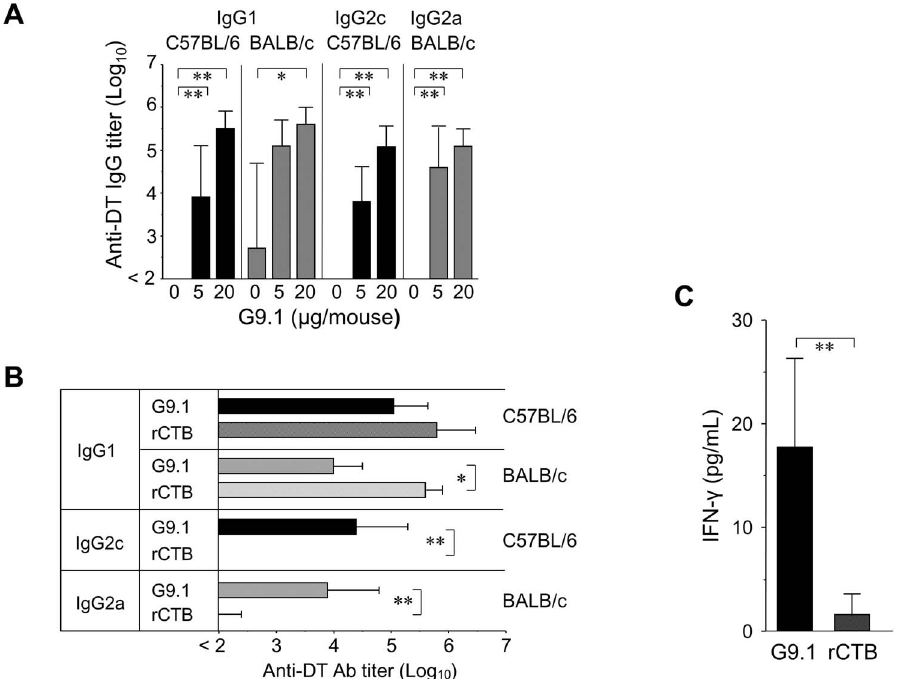
Figure 4. Nasally administered G9.1 induced both IgG1 and IgG2a/c production. A , C57BL/6 and BALB/c mice were immunized as described in Fig. 3. B, C57BL/6 and BALB/c mice were administered DT (2 Lf) with G9.1 (20 m g) or rCTB (10 m g). Serum titers of anti-DT IgG1, IgG2a (BALB/c), and IgG2c (C57BL/6) Abs were measured as in Fig. 3. * p , 0.05 and ** p , 0.01 as determined by ANOVA followed by post hoc Tukey’s test or by t -test; n=5. Experiment A and B were repeated thrice and twice, respectively, yielding nearly identical results. C, Splenocytes isolated from BALB/c mice vaccinated with DT (2 Lf) plus G9.1 (20 m g) or DT plus rCTB (10 m g) were cultured for 24 h with 10 m g/mL DT. IFN- c concentration in the culture supernatant was measured by ELISA. ** p , 0.01 as determined by a t -test